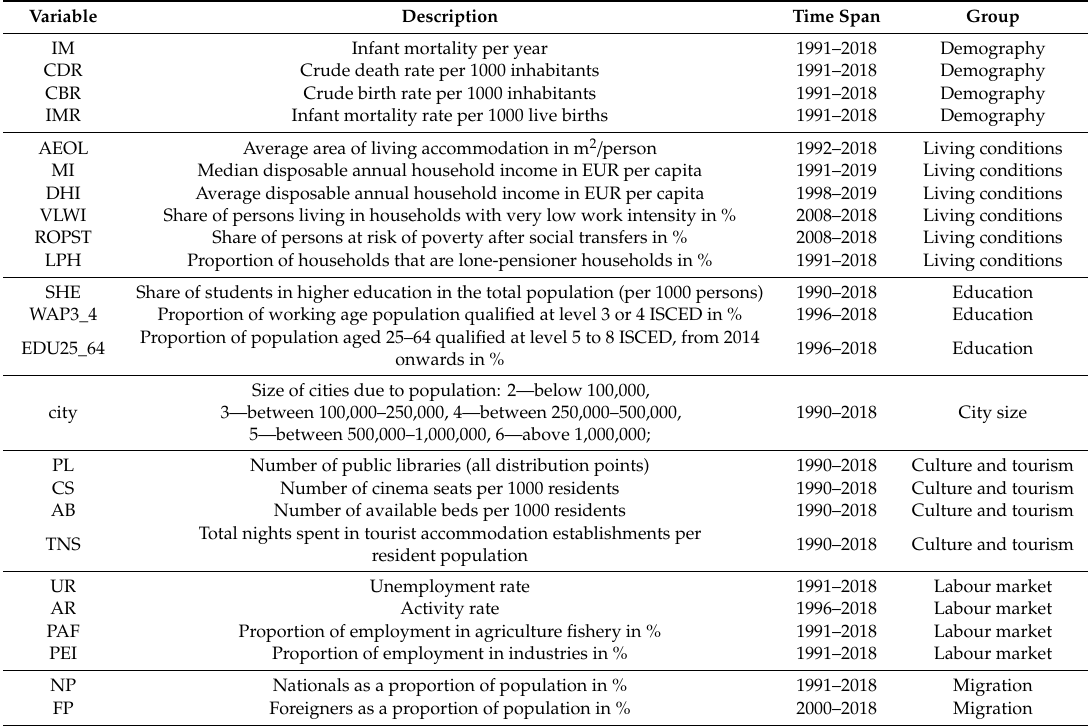
Table 2. Potential determinants of the proportion of elderly people (aged 65 or above) who live in European